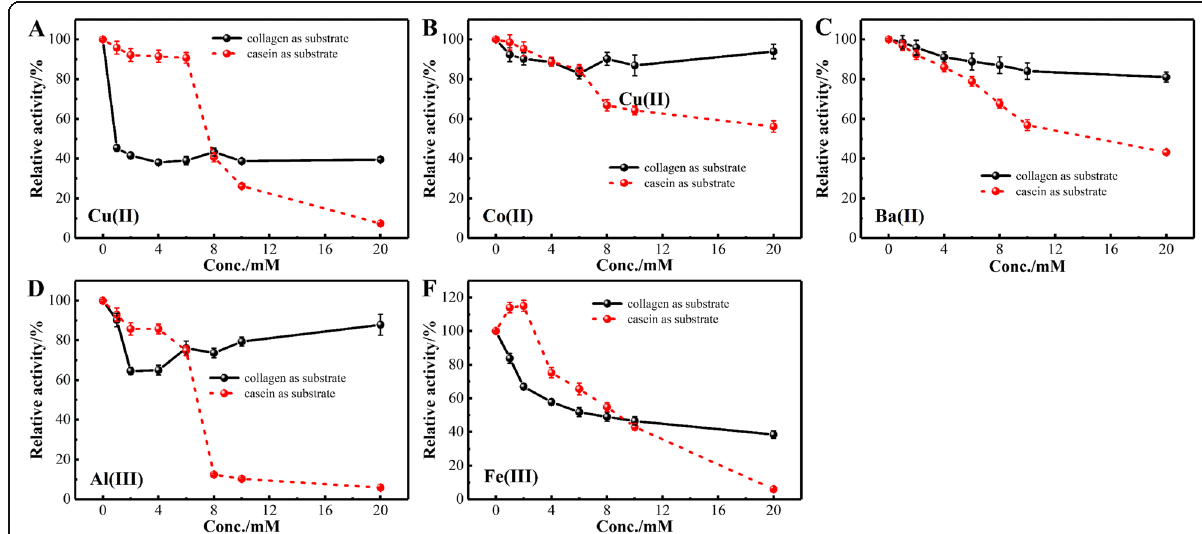
Fig. 1 The effect of metal ions on the hydrolytic activity of proteinase